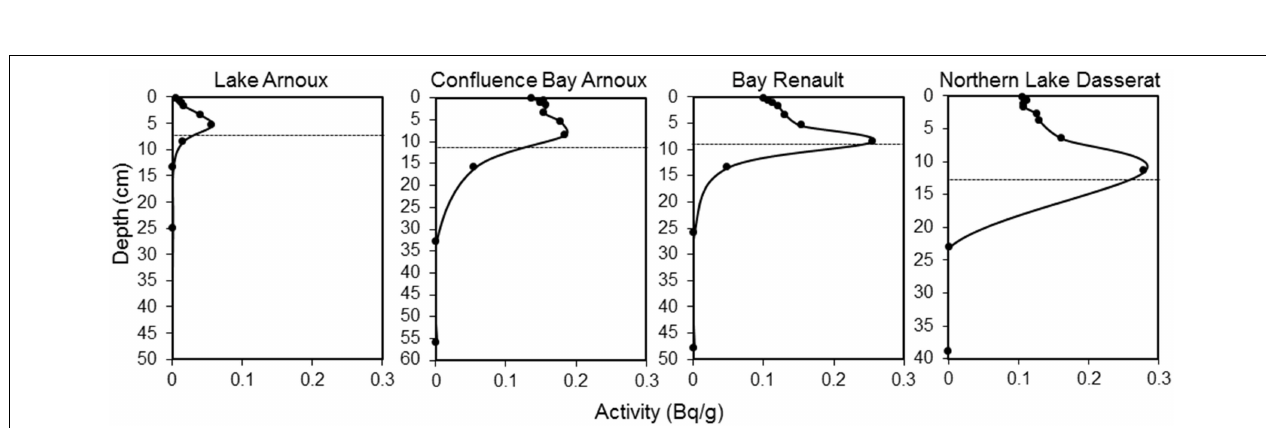
FIGURE 3 | Plots of 137 Cs activity as a function of depth (cm) for each of the four cores. The dotted line corresponds to the year 1963–1964 based on sedimentation rates calculated from 210 Pb